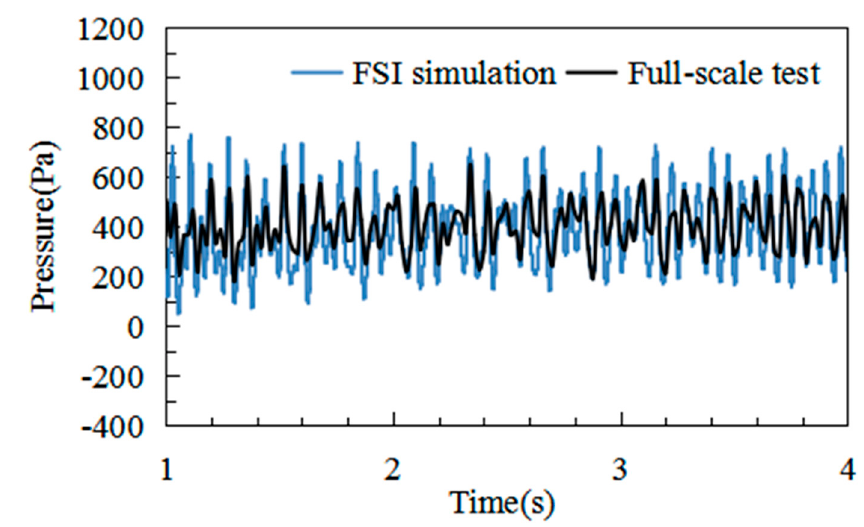
Figure 5. Data for the surface pressure on the rubber external windshield.